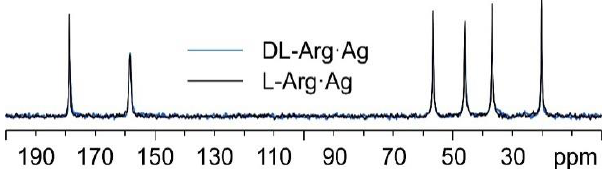
Figure 8. Overlay of the 13 C CPMAS spectra of L-Arg·Ag (in black) and DL-Arg·Ag (in blue).